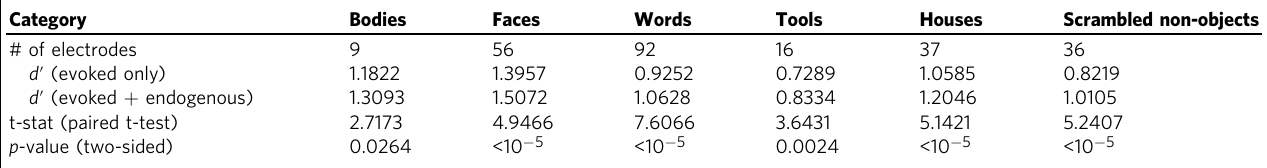
Table 1 Comparisons of the classi fi cation results for each